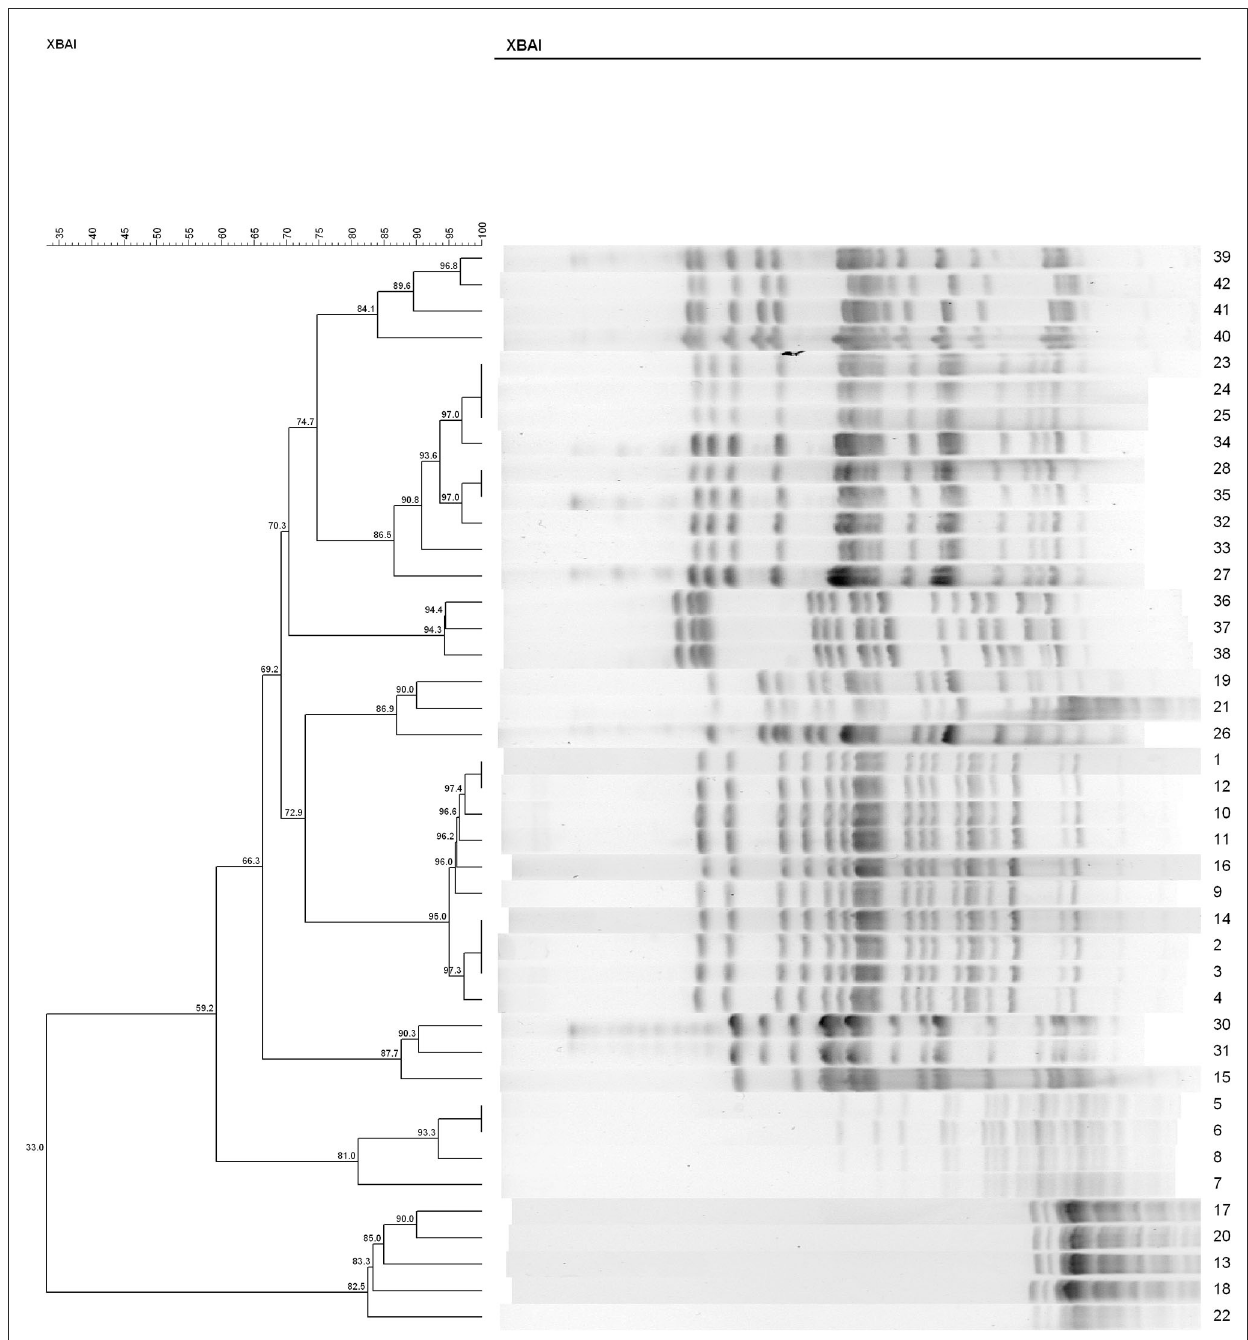
FIGURE4 The PFGE of cefotaxime-sensitive or -resistant isolates from one rat’s fecal samples in C − group. Numbers 1–34 indicates indigenous sensitive E. coli isolates; numbers 35–42 indicate bla CTX − M -positive E. coli isolates.